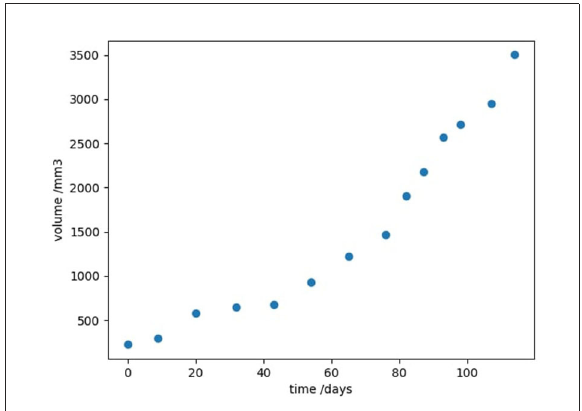
FIGURE1 Experimental data showing the growth of tumor volume with time, in a mouse model of human breast cancer, taken from Kühleitner et al.